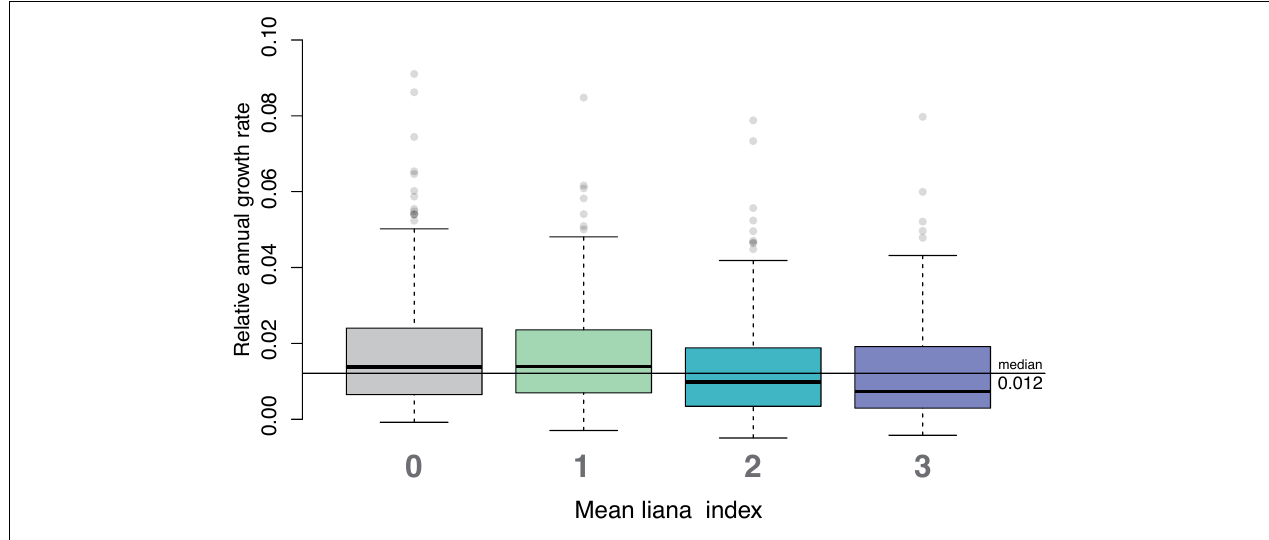
FIGURE 2 | Overall median relative growth rates for trees with different average liana index over all study years. Trees with liana index of 0 and 1 had significantly higher relative growth than trees with lianas present in more than 10% of the tree’s crowns.